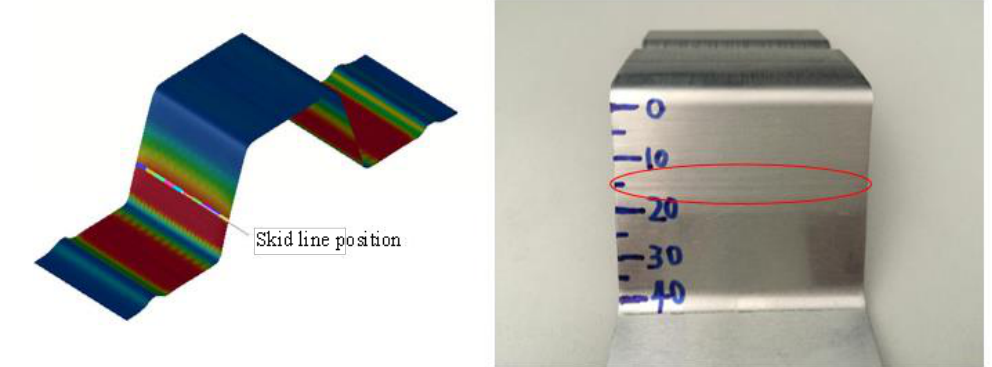
Figure 13. Comparison of simulation and experiment.